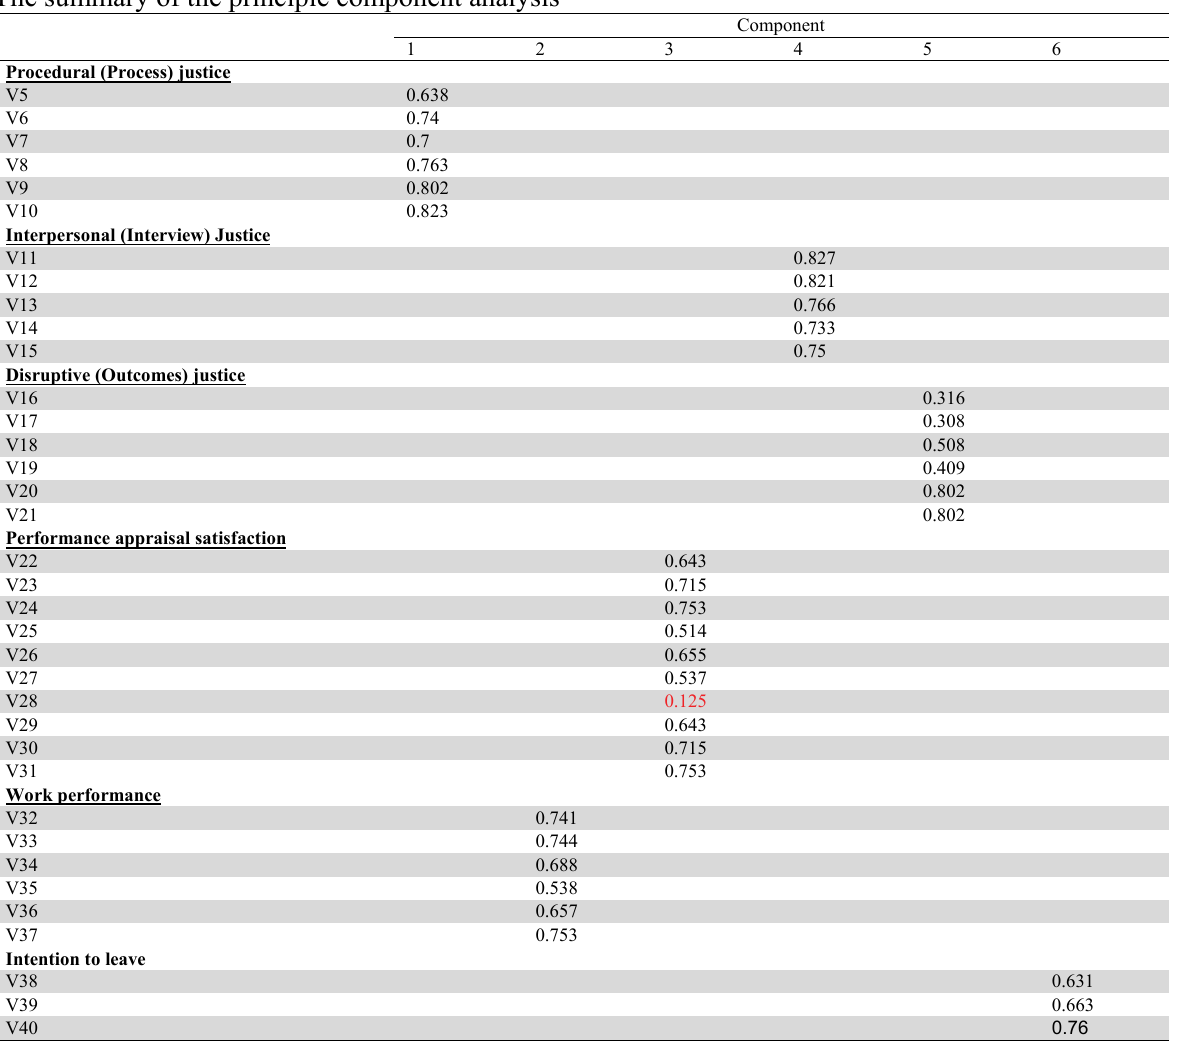
The summary of the principle component